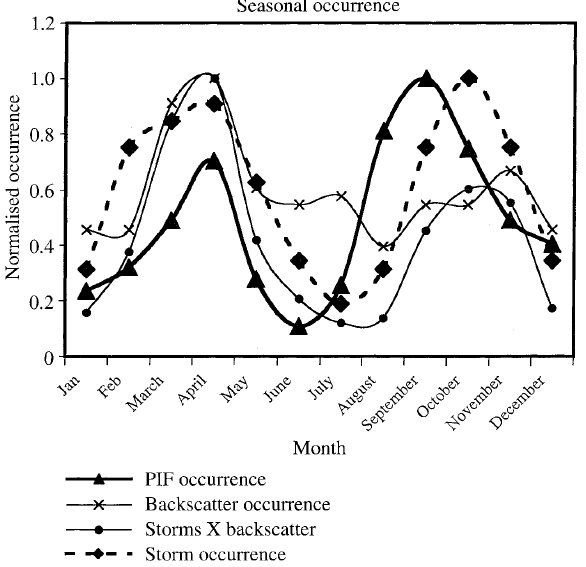
Fig. 6. Normalised occurrence of days per calendar month from March 1995 to February 1997 on which PIF signatures were observed by the CUTLASS Finland radar when run in a normal scan mode, compared with the occurrence of backscatter from the CUTLASS Finland radar and the occurrence rate of geomagnetic storms 0848 UT, these times are marked with vertical dashed lines on the LTV plots. Two polar plots for 0640 UT and 0848 UT are also shown. Beam 2 (marked with a black line on the polar plot produced at 0640 UT) detected the PIF signature first at ~ 0700 MLT, while beam 11 (marked with a black line at the polar plot produced at 0848 UT) observed the final PIF signature at ~ 1300 MLT. So for this day PIF signatures were observed for a duration of 6 h of MLT.